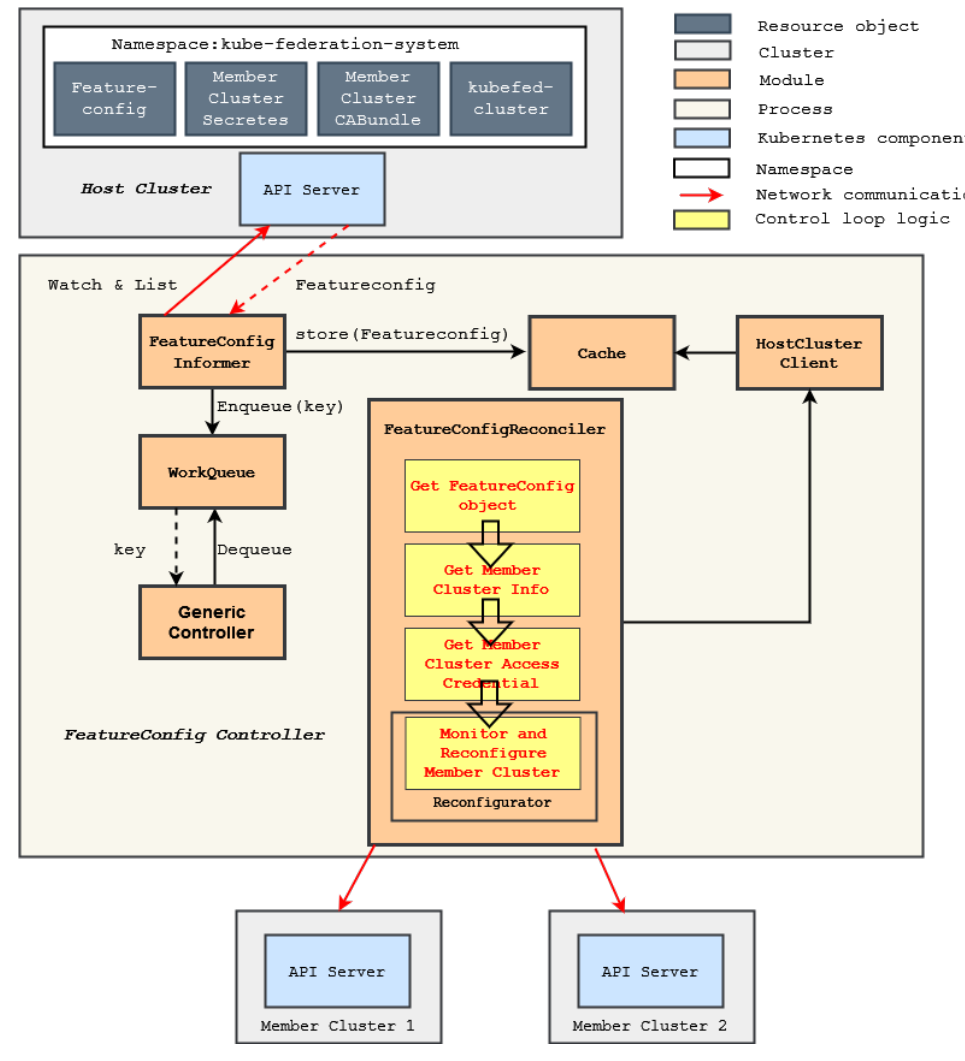
Figure 8. Architecture of the